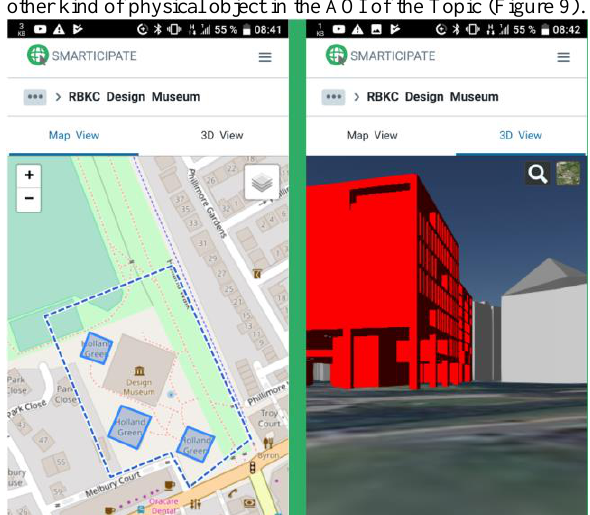
Figure 9. smarticipate Front-End – Mobile View © AIT